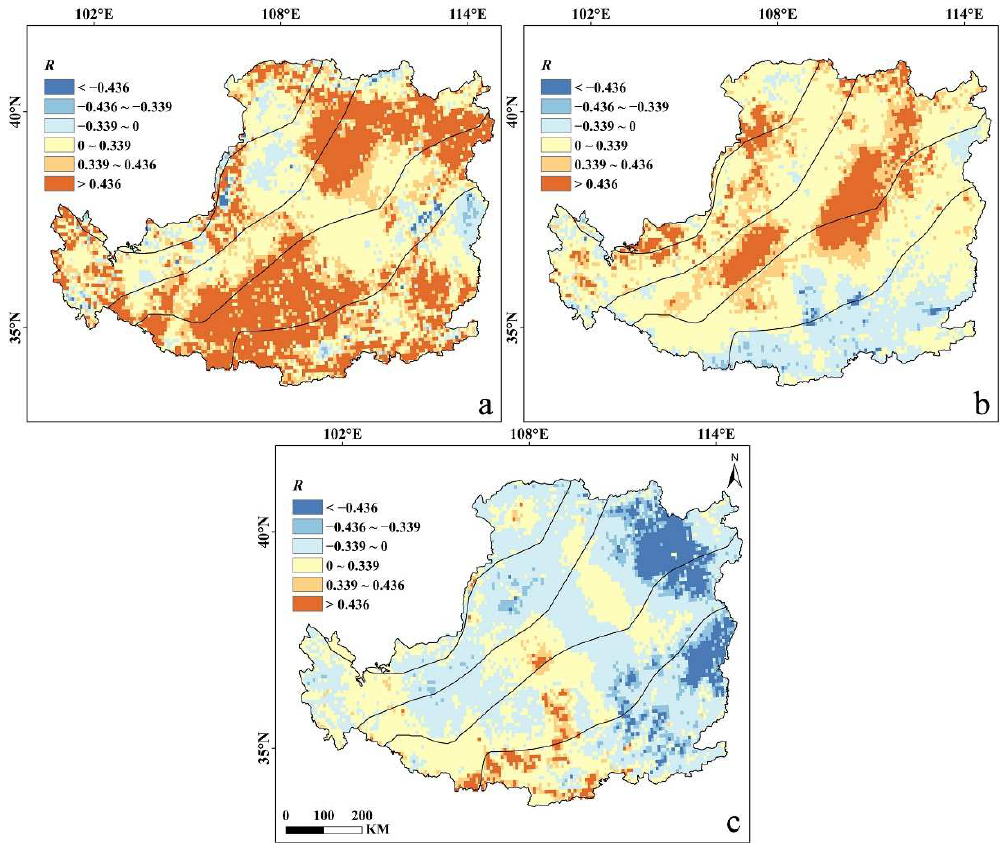
Figure 9. Spatial distributions of response relationships between NDVI and ( a ) temperature, ( b ) precipitation, and ( c ) solar radiation. The absolute values of R greater than 0.339 represent significant correlations ( p < 0.05).